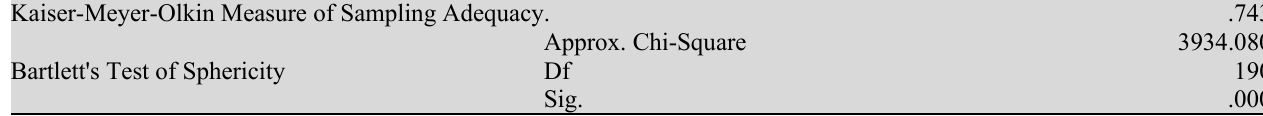
KMO and Bartlett's Test Kaiser-Meyer-Olkin Measure of Sampling